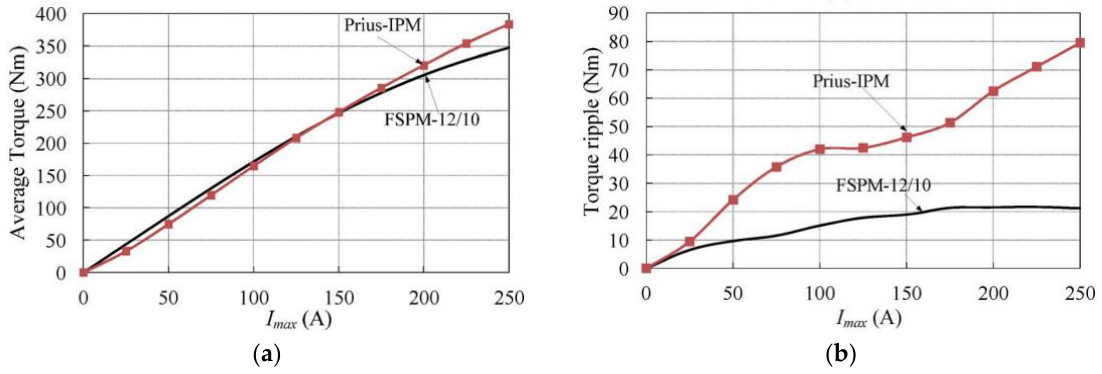
Figure 14. The torque performance of the Prius-IPM and FSPM motor [103]: ( a ) Average output torque; ( b ) Peak-to-peak torque ripple. Table 5. Quantitative comparison of Prius-IPM and FSPMM